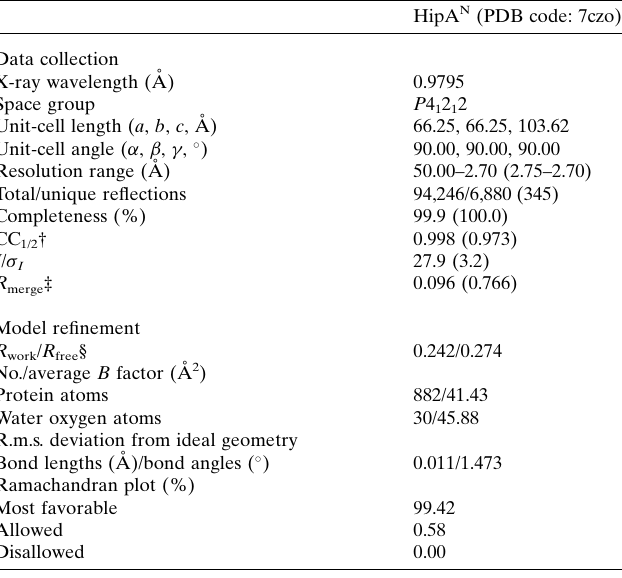
Table 2 Statistics for data collection and model refinement. Values in parentheses refer to the highest-resolution